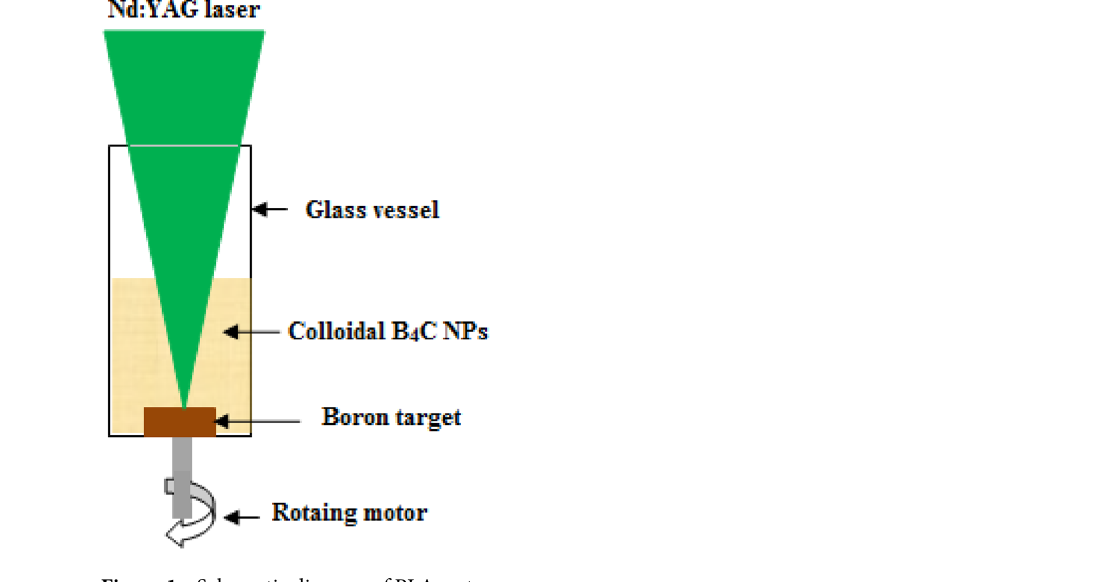
Figure 1. Schematic diagram of PLA